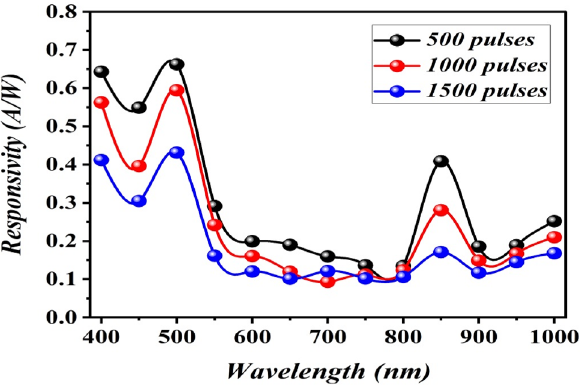
Figure 15. Spectral responsivity plot of B 4 C/p-Si photodetectors fabricated at different number of laser pulses.